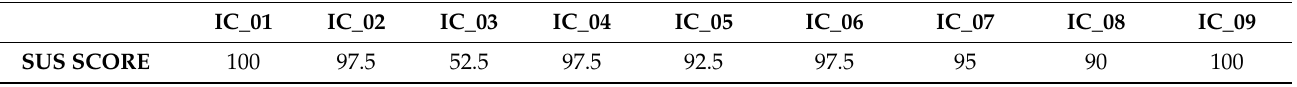
Table 8. SUS scores of informal caregivers ar the end of the